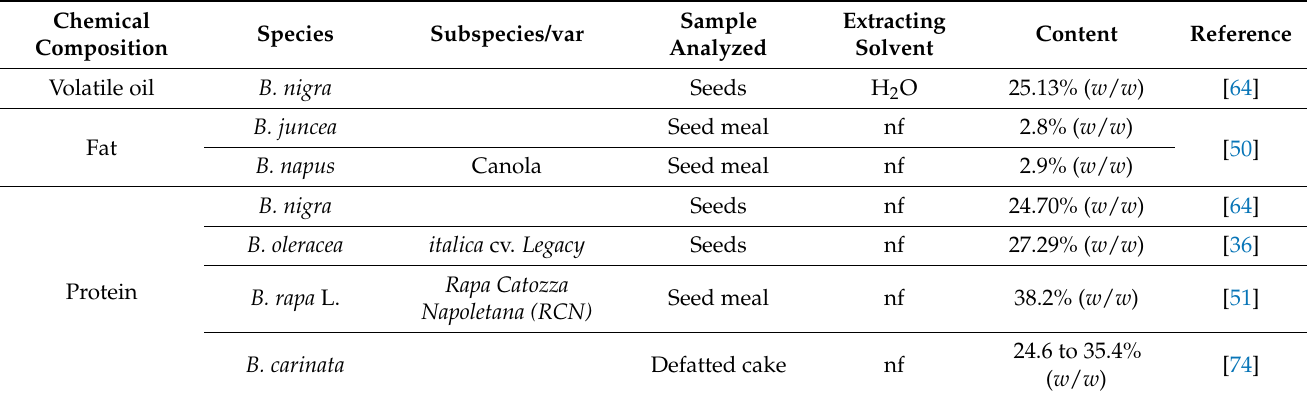
Table 3. Chemical composition of Brassica spp. seeds, their derivatives (oil, meal, and cake), and sprouts obtained with different extracting solvents